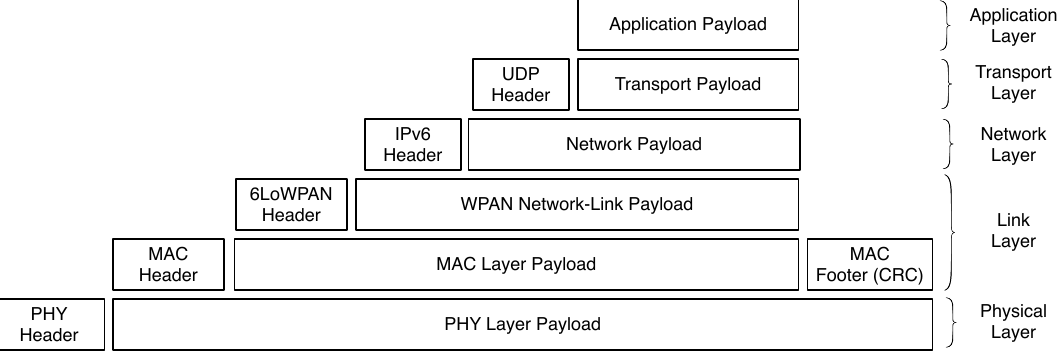
Figure 5. Communication stack from a particular integration board and a hub in the proposed